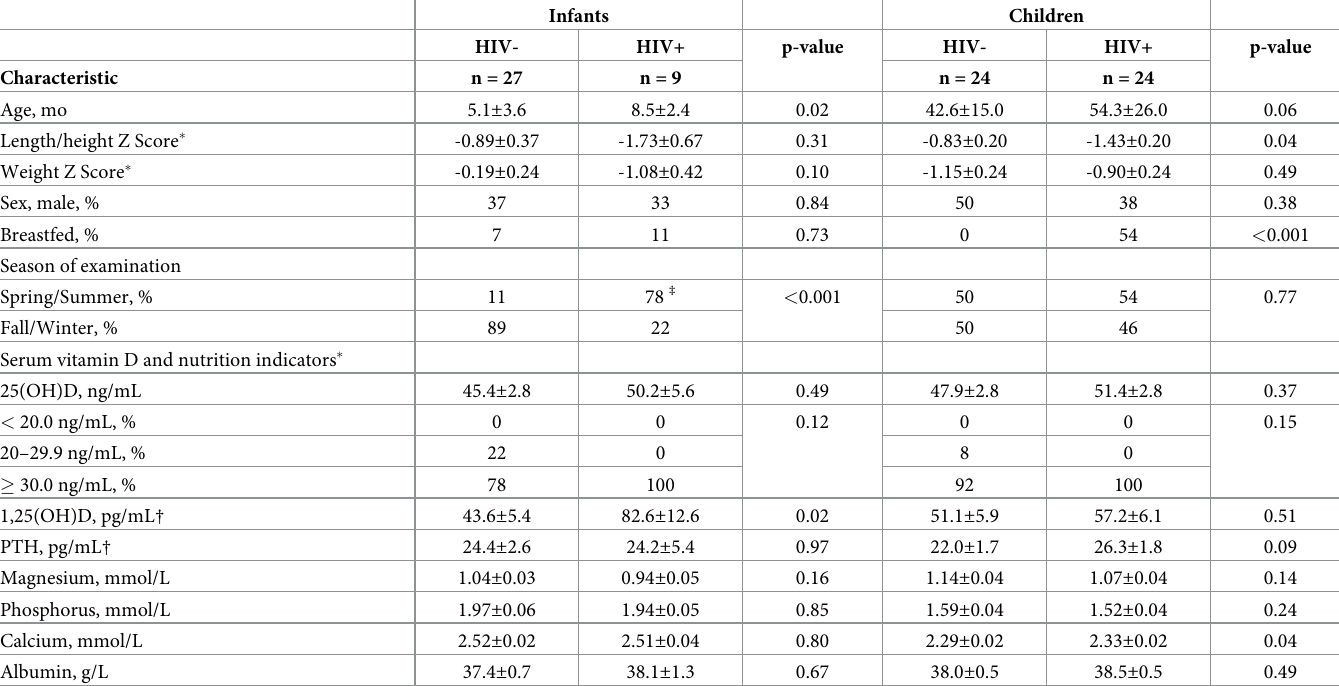
Table 2. Infant (n = 36) and child (n = 48) characteristics stratified by HIV status.